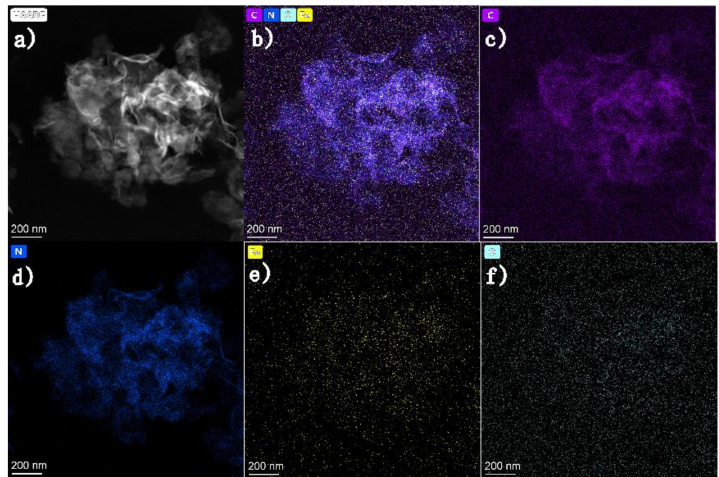
Figure 3. EDS mapping of 2Fe( Ш )-CN: ( a ) HAADF image; ( b ) multi-elemental image of C, N, Fe and O; ( c ) C element map; ( d ) N element map; ( e ) Fe element map; ( f ) O element